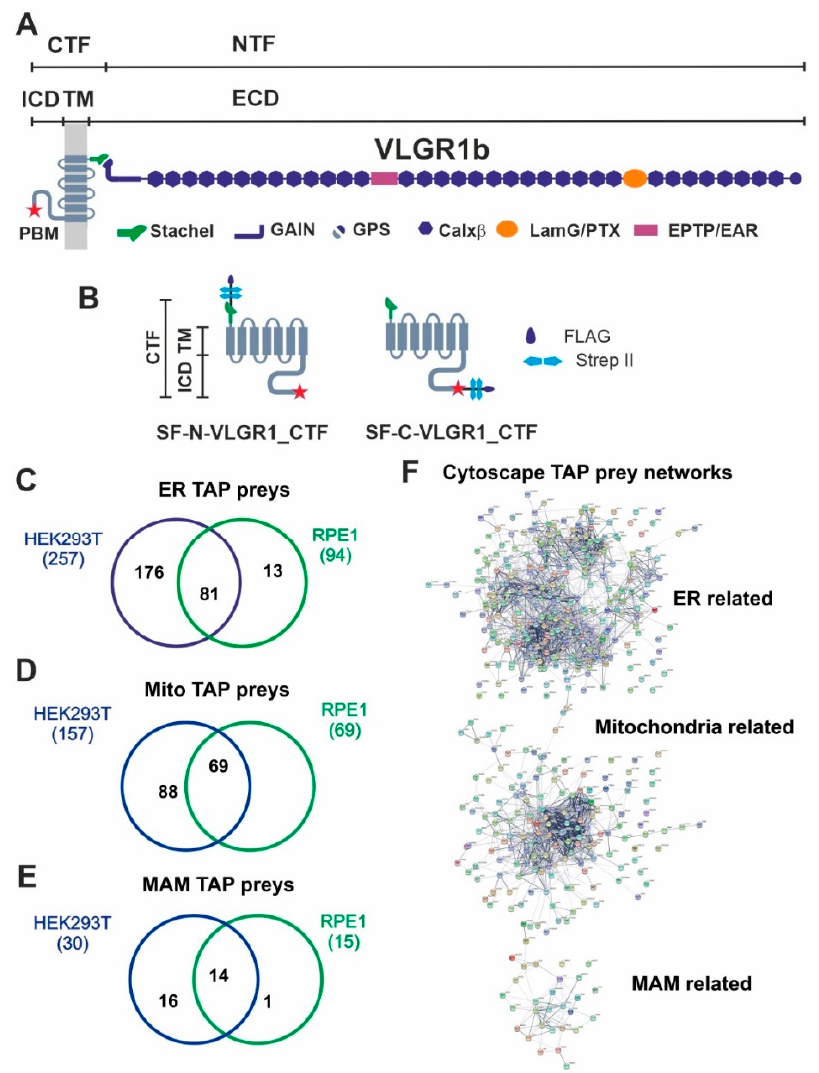
Figure 1. VLGR1 protein domain composition, VLGR1_CTF constructs for TAPs and overlap of proteins associated to ER, mitochondria and MAM identified in VLGR1_CTF TAPs. ( A ) VLGR1 protein domain composition: VLGR1 molecules consist of a C-terminal fragment (CTF) and a N-terminal fragment (NTF) which result from the cleavage at the highly conserved GPCR proteolytic site (GPS) in the GAIN (autoproteolysis-inducing) domain positioned next to the seven-span transmembrane domain (TM). After autoproteolytic cleavage the first 11 amino acids of VLGR1_CTF, the so-called Stachel peptide, can act as a tethered internal agonist for receptor activation [3]. The extracellular domain (ECD) of VLGR1b contains numerous Ca 2+ binding calcium exchanger β motifs (Calx- β ), seven epilepsy-associated/Epitemptin-like (EAR/EPTP) repeats and a pentaxin/laminin G-like domain (LamG/PTX). The intracellular domain (ICD) ends with a class-1 PDZ binding motif (PBM). ( B ) VLGR1_CTF, N- or C-terminal tagged with Strep II/FLAG (SF)-tag used as baits in TAPs. ( C ) Venn diagram shows an overlap of 81 proteins of ER-related TAP prey for polled VLGR1_CTF N-and C-terminal tagged TAPs from HEK293T and hTERT-RPE1 cells. ( D ) Mitochondria-related prey proteins from VLGR1_CTF N-and C-terminal tagged TAPs in HEK293T and hTERT-RPE1 cells, compared in a Venn diagram with an overlap of 69 proteins. ( E ) 14 common MAM prey proteins are identified in TAPs from HEK293T and hTERT-RPE1 cells. ( F ) Protein networks of ER, mitochondria and MAM-related proteins, illustrated by Cytoscape analysis of preys identified in VLGR1_CTF N-and C-terminal tagged TAPs.